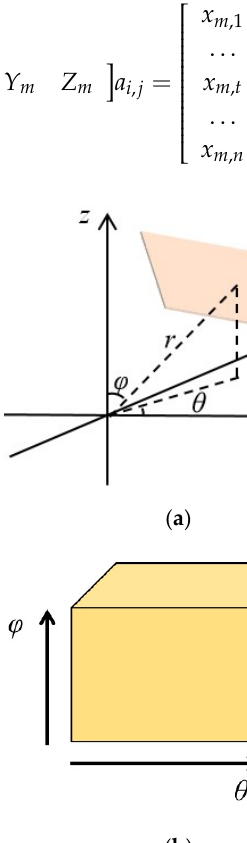
Figure 2. The graphical illustration of a Cartesian coordinate and a 3D Hough space. ( a ) The Cartesian coordinate. ( b ) The Hough space.